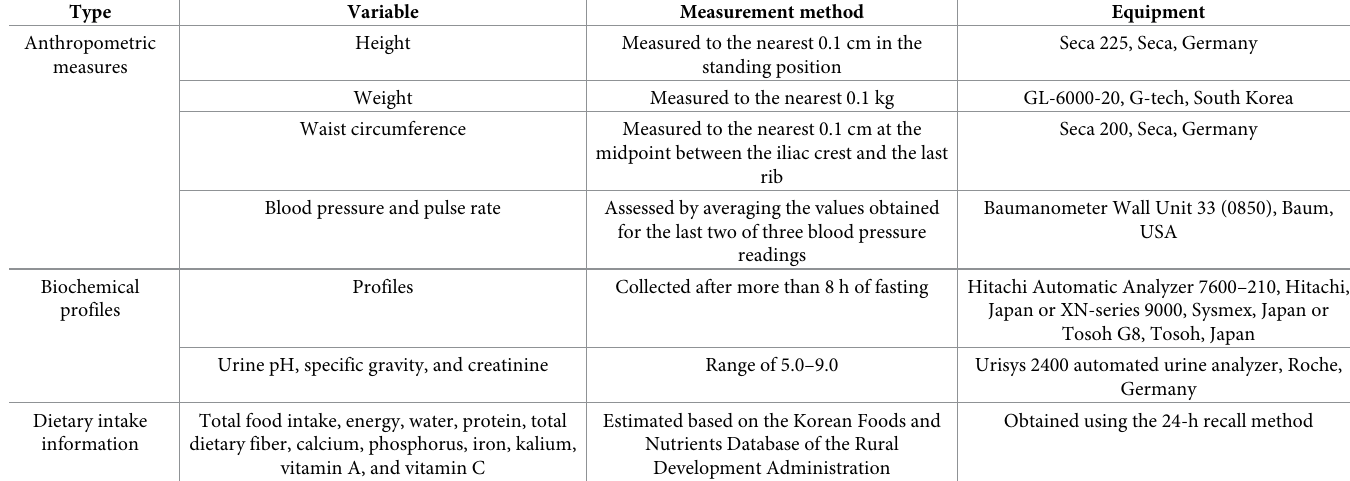
Table 1. Measurements of the variables used in this